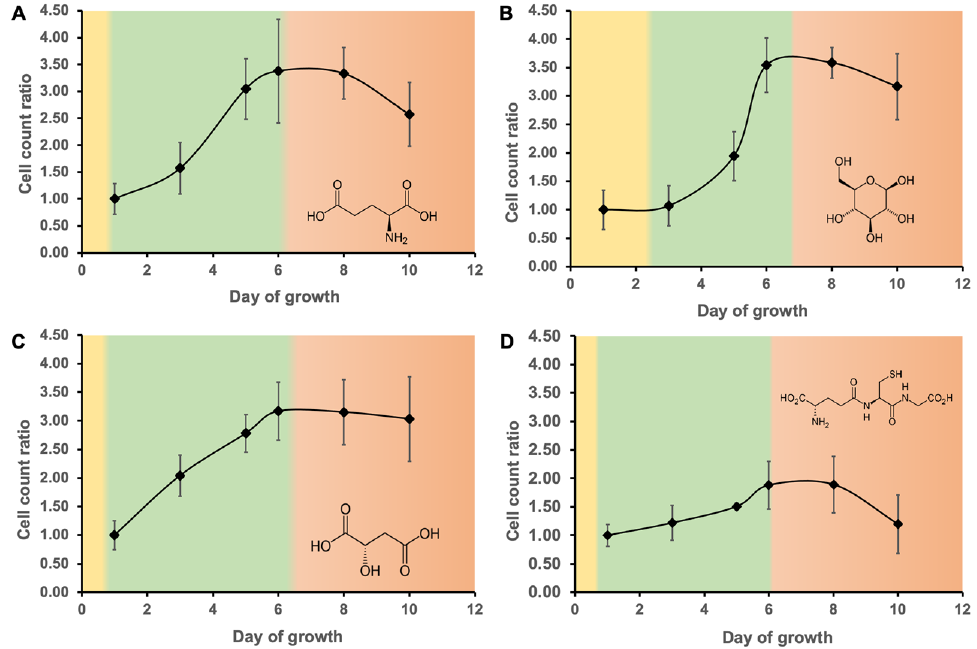
Figure 1. Growth curve and the different phases with ( A ) glutamic acid, ( B ) glucose, ( C ) malic acid and ( D ) GSH amendment during lag (yellow), log (green), and stationary phases (red).